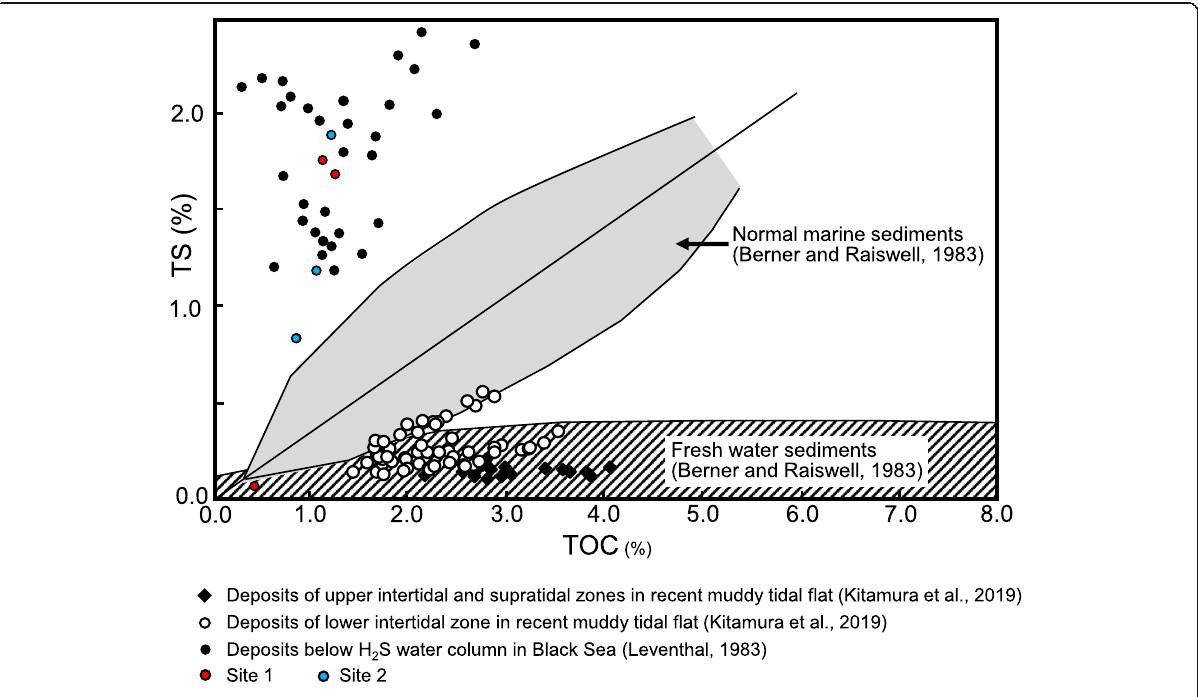
Fig. 4 Scatter plots of TS versus TOC for the cored sediments, and marine and freshwater sediments